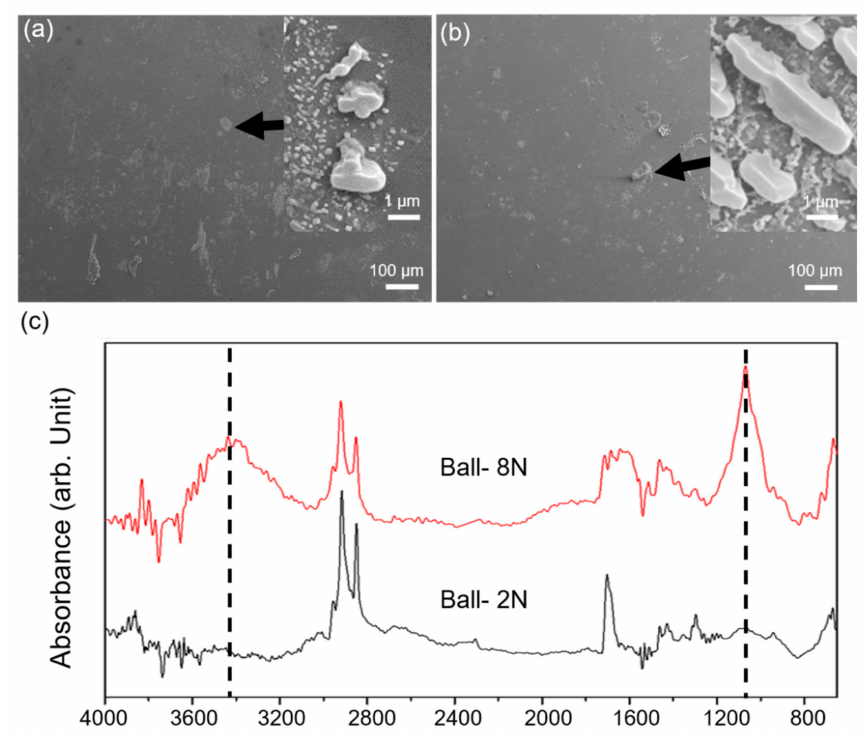
Figure 6. Surface observation of upper counter ball, ( a ) 2 N, ( b ) 8 N, ( c ) ATR-FTIR analysis on the counter ball surface (SA20H, 1 m).